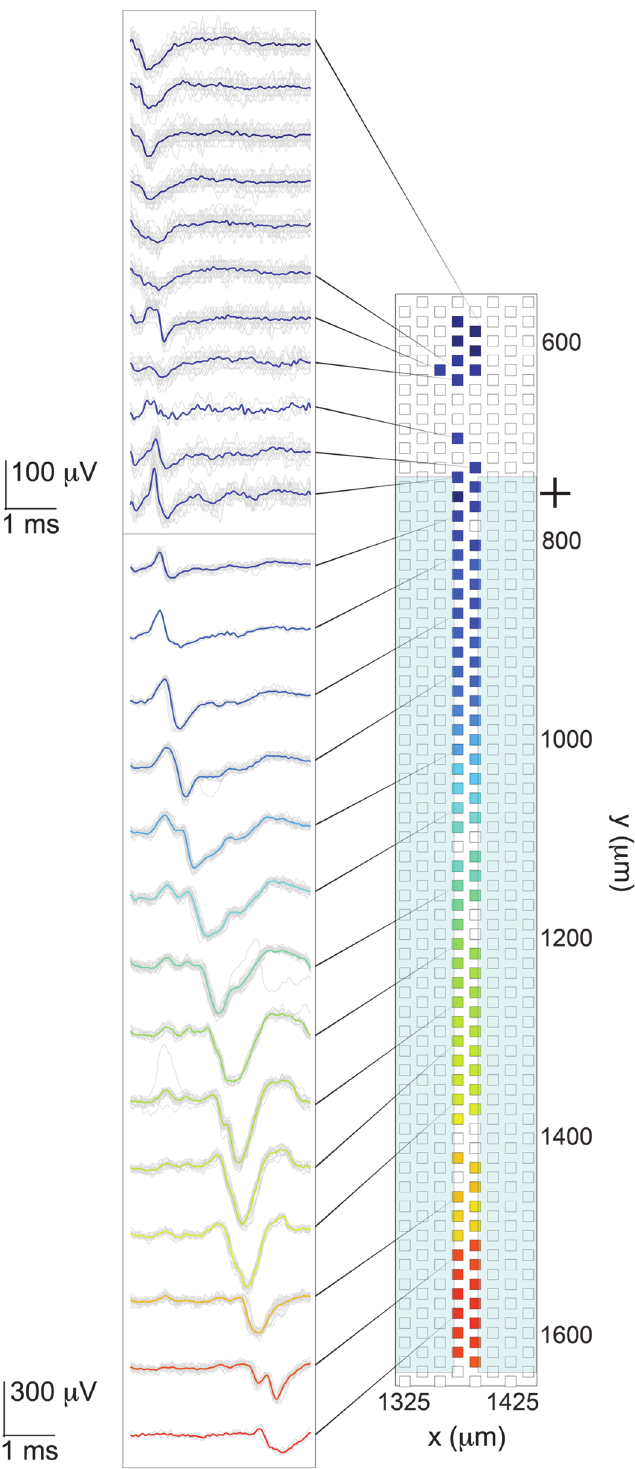
Fig 10. Spike propagation following stimulation in channel. Invasion of an action potential into the soma and subsequent propagation through a channel; colors convey timing information and correspond to the colors of the electrodes depicted on the right. Thirty trials (in grey) for each electrode were overlaid with the median signal. The dark blue somatic spike gives way to a smaller axonal spike, which at first was hard